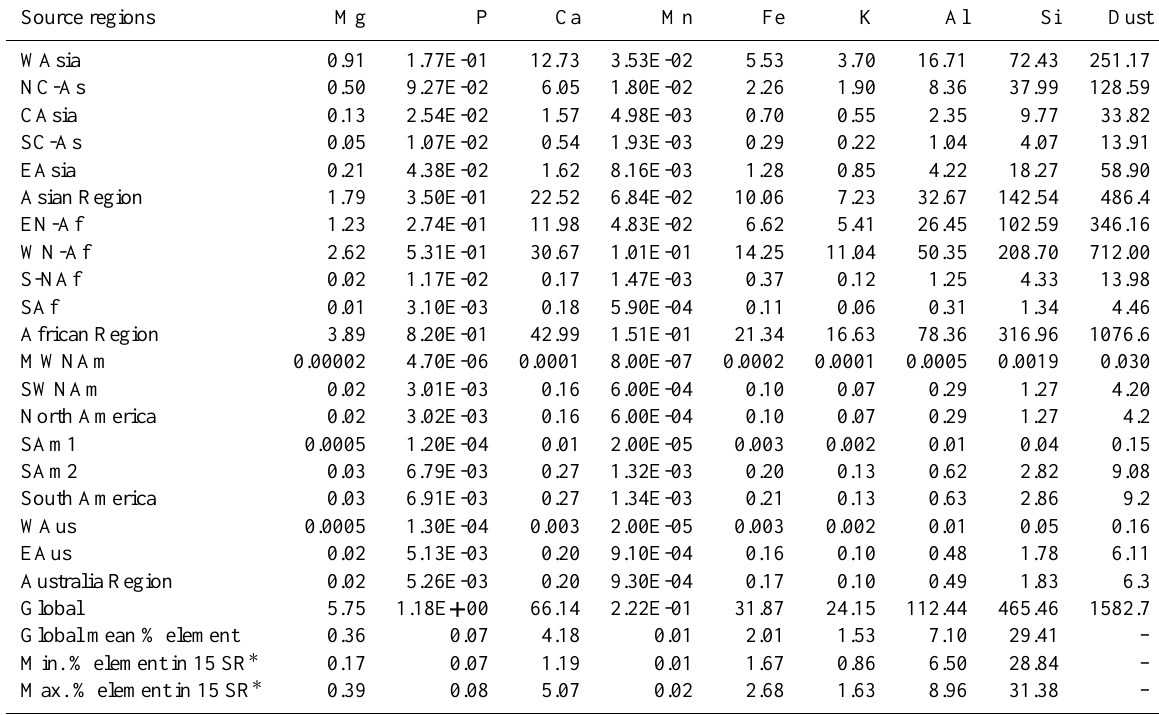
Table 2. Ten-year-averaged emission rates (Tgyr − 1 ) and percentages of elements over desert regions. (For this table, annual mean emission of each element is divided by the annual mean emission of dust to obtain the percentage).